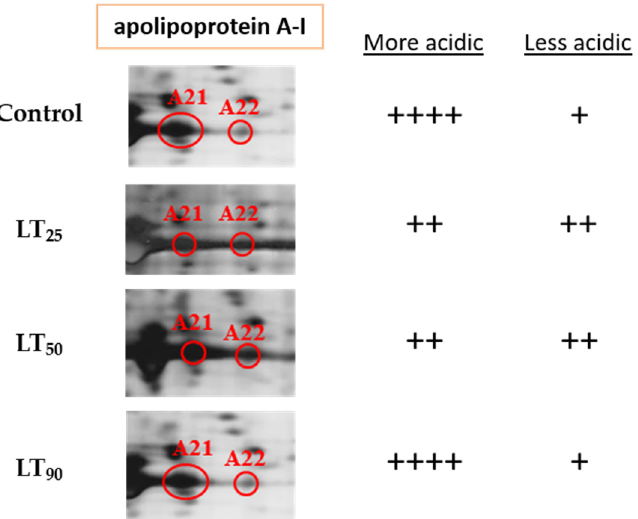
Figure 4. Magnified protein spots of apolipoprotein A-I showing the possible interconversion between the two isoforms over the time course of exposure experiment. The number of positive signs denotes the relative protein abundance.